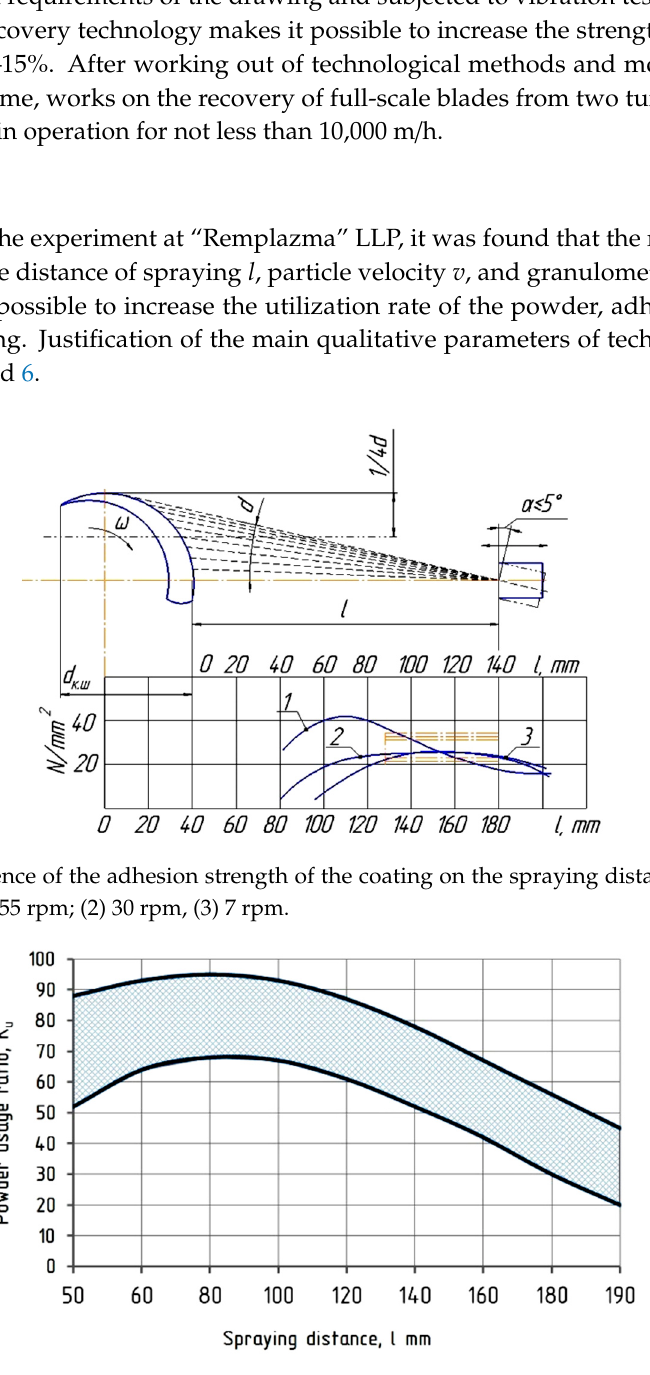
Figure 6. The dependence of the powder PN55T45 utilization coefficient.